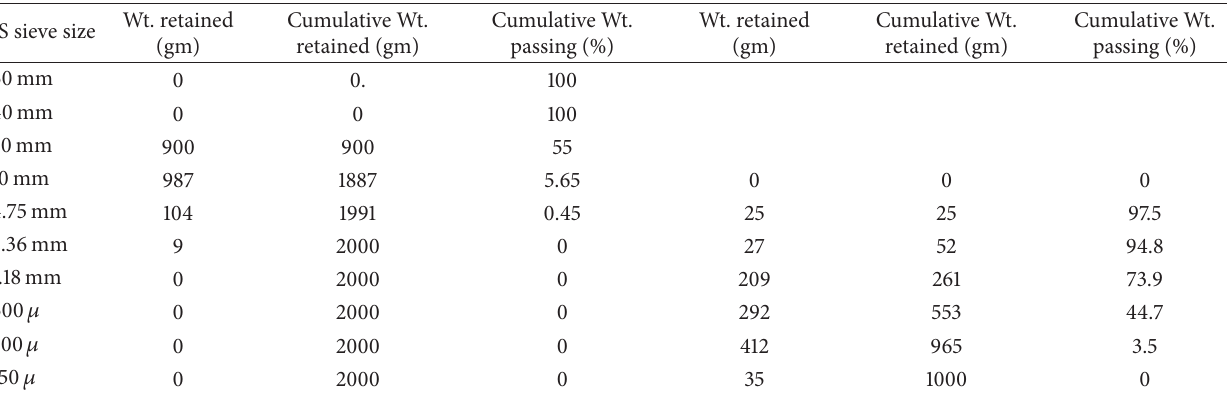
Table 4: Sieve analysis of coarse aggregates.